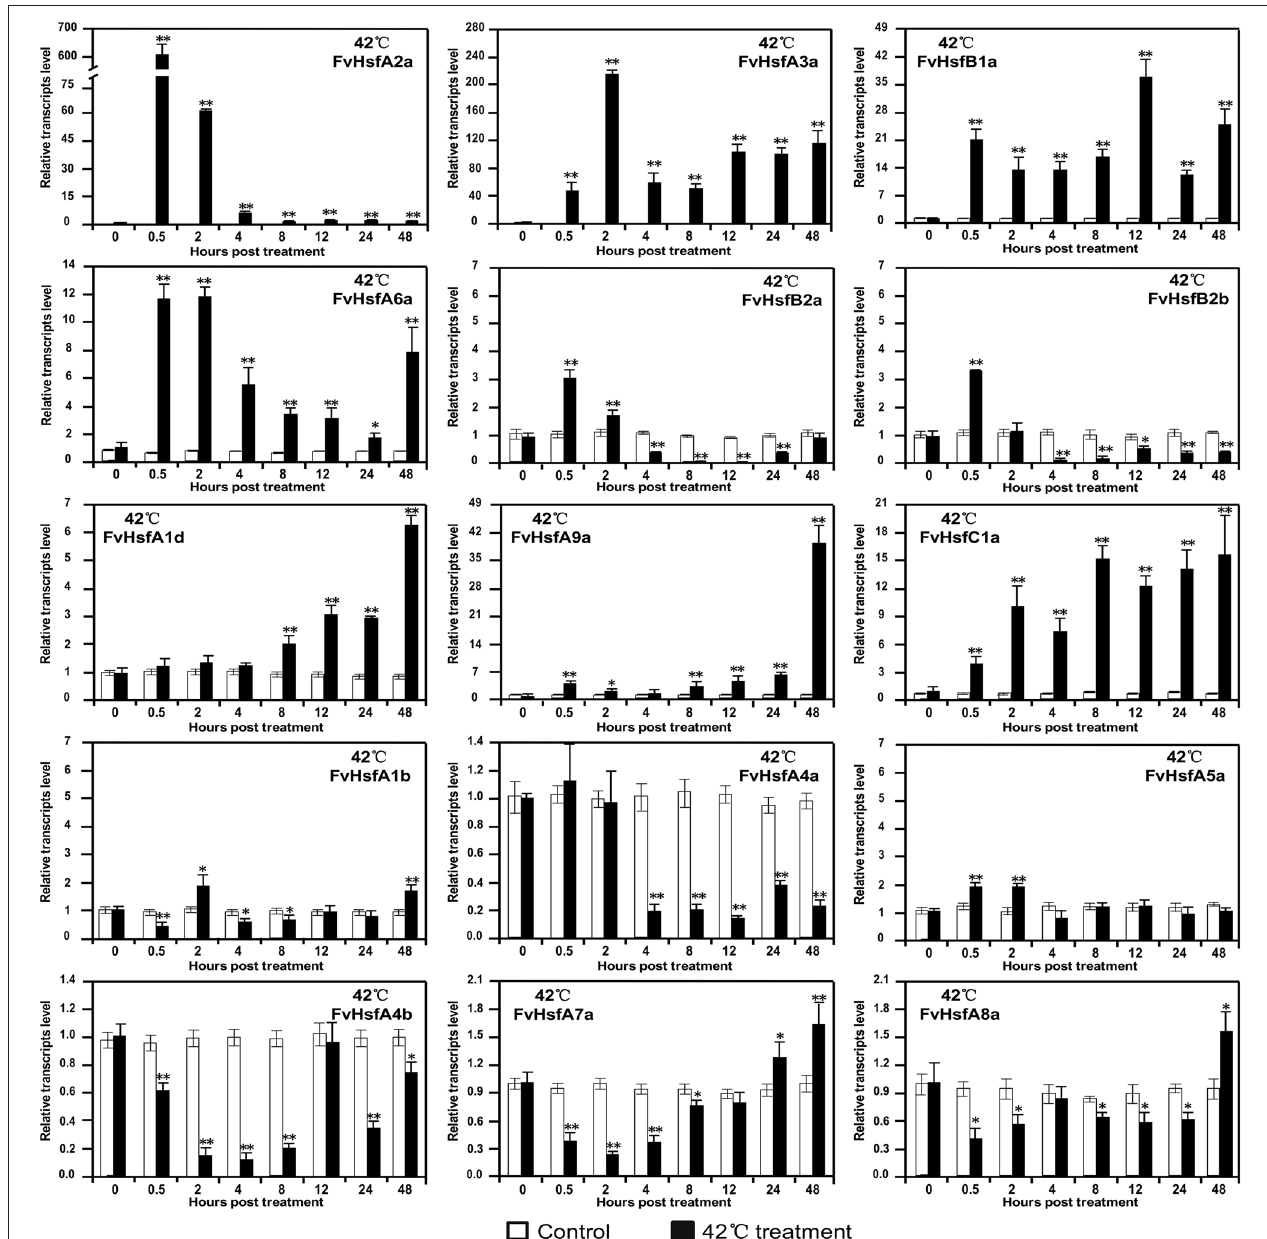
FIGURE 6 | The expression of FvHsf genes in the diploid woodland strawberry ( F. vesca ) in response to 42 ◦ C treatment. Real-time quantitative PCR was performed to determine the expression of various FvHsfs in 42 ◦ C temperatures relative to control temperatures. The analysis results were normalized using Fv18s . The experiments were repeated three times and gave consistent results. The mean values and SDs were obtained from three biological and three technical replicates. The asterisks indicate that the corresponding gene was significantly up or down-regulated in response to treatment, as determined by the Student’s t -test ( * P < 0 . 05 , ** P < 0 . 01